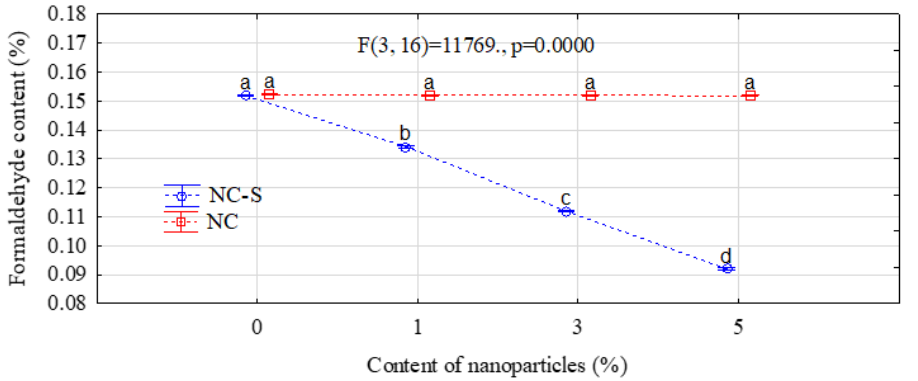
Figure 5. The ability of NC and NC-S to absorb the formaldehyde (letters a, b, c, and d mark homogeneous groups in HSD Tukey test).